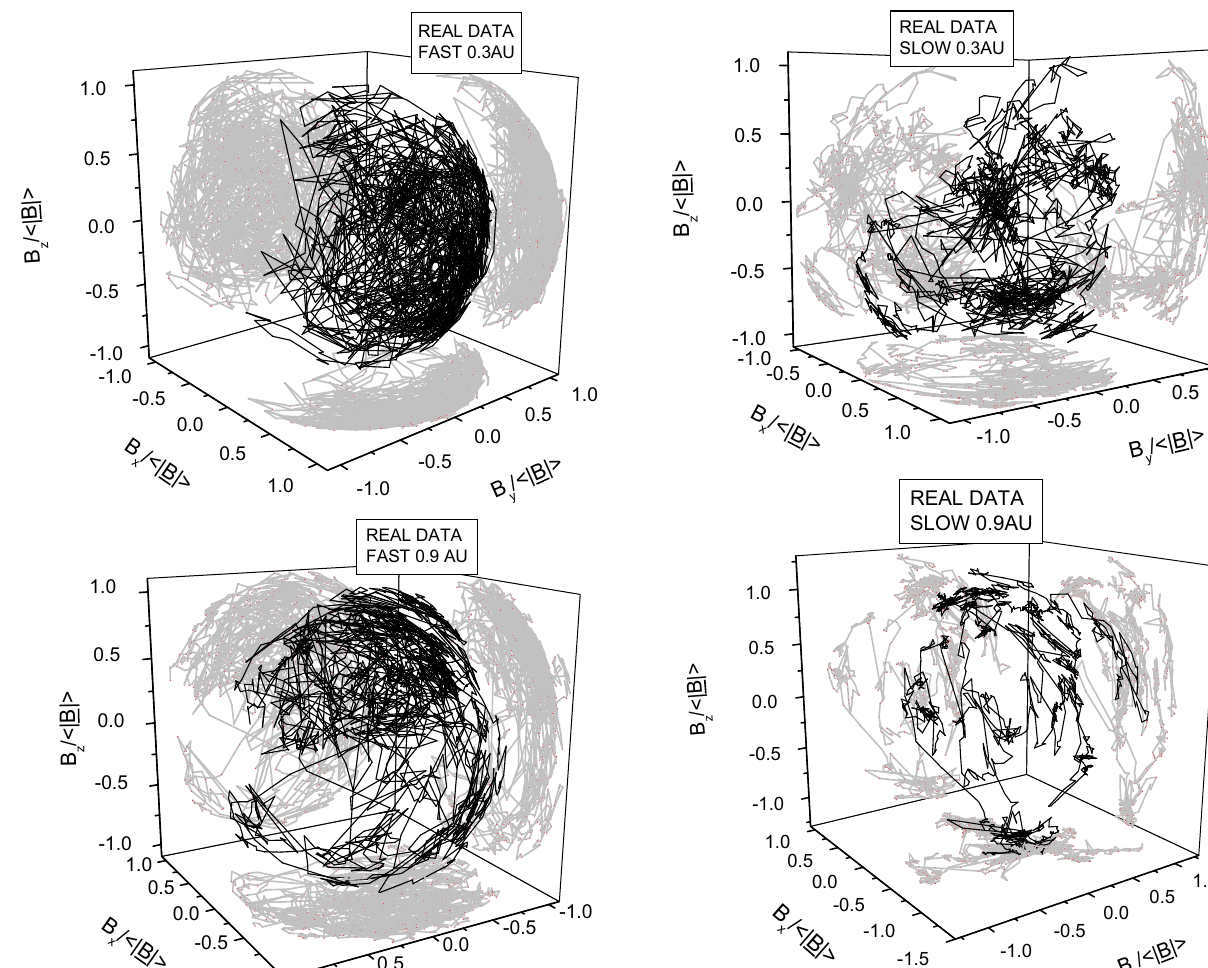
Fig. 2. The top panel refers to a fast wind recorded at 0.3AU while the bottom panel refers to a fast wind at 0.9AU. Each point of both plots represents the location of the tip of the magnetic field vector for each 6-s average. These locations have then been connected by a black straight line to form a trajectory. Moreover, the shadow of this trajectory is also shown on the three coordinate planes to better understand the spatial 3-D configuration. In these panels we show only intervals of 2000-point representing larger intervals of 28800 6-s averages. Values of each component have been nor- malized to the average magnetic field intensity measured within the 2000 points interval. The top panel shows a more uniform coverage with respect to the bottom panel, which shows a sort of patchy con- figuration. In other words, there is some kind of evolution during the radial expansion which is dramatically reflected in this kind of spatial behaviour. still wanders on the surface of only half a sphere, it does not cover this surface completely but leaves out wide areas. of preferred spatial directions, connected by large and quick jumps which take only a few data points, begins to emerge as the heliocentric distance increases.